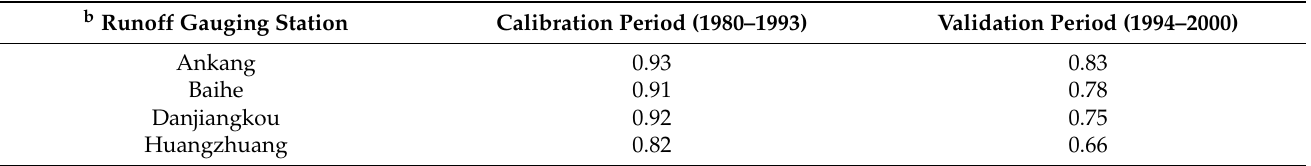
Table 3. The NSE values during the calibration and validation periods range from 0.66 to 0.93, suggesting that the calibrated SWAT model can apply to project the future runoff. Table 3. The NSE values at the four runoff gauging Table 3. The NSE values at the four runoff gauging stations.